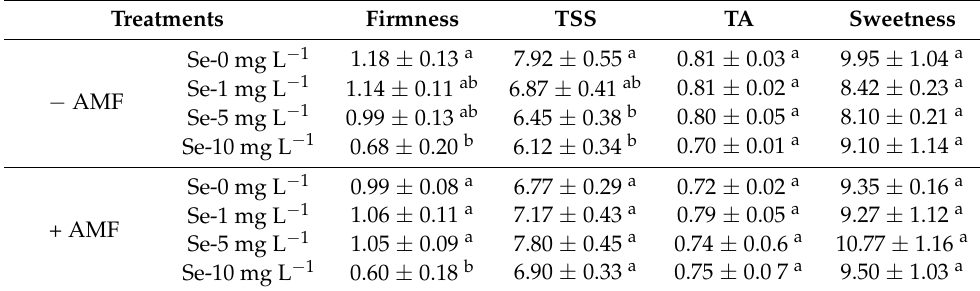
Table 3. Effects of arbuscular mycorrhizal fungi (AMF) inoculation and selenium (Se) levels (0, 1, 5 and 10 mg L − 1 ) in the nutrient solution on fruit firmness (N), total soluble solids ( ◦ Brix), titratable